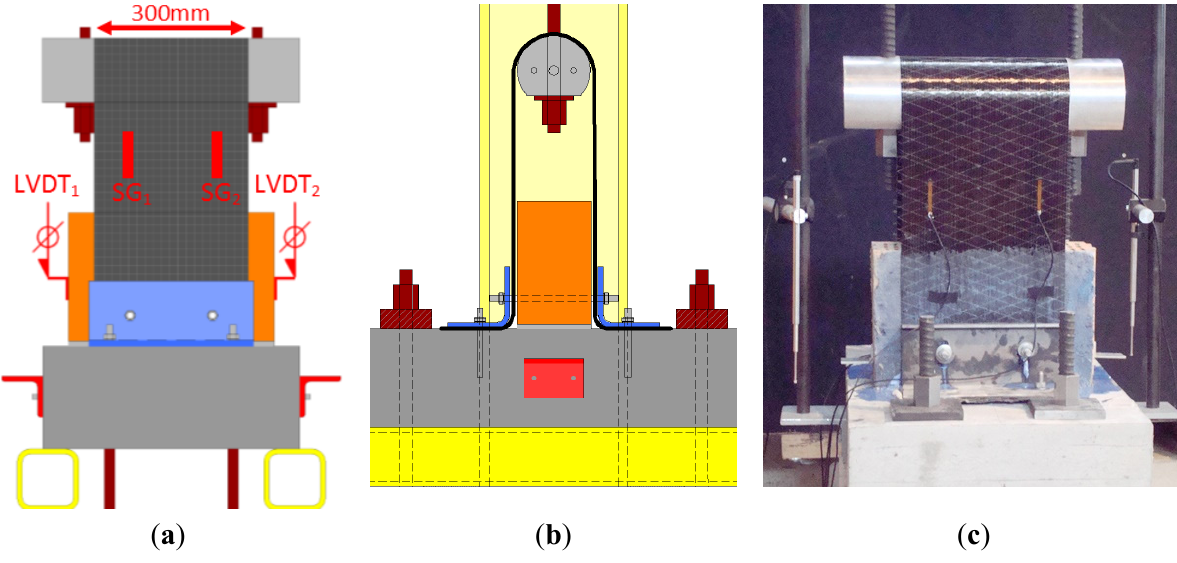
Figure 13. ( a , b ) Model with instrumentation of specimen in Series AT-C in view and sectional drawing; ( c ) Specimen of Series AT-C.